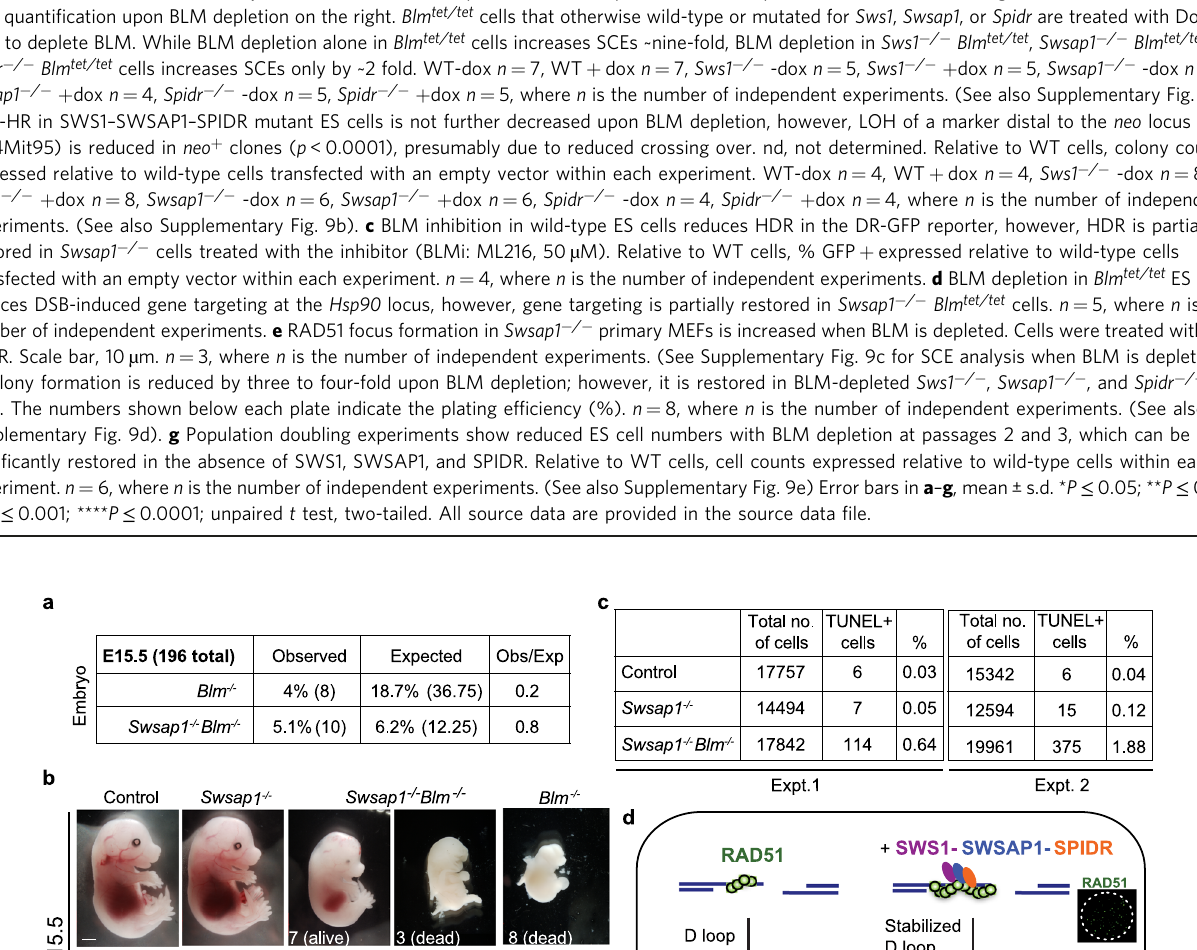
Fig. 3 Mitotic phenotypes associated with BLM depletion are dramatically ameliorated by loss of SWS1 – SWSAP1 – SPIDR. a . Loss of SWS1 – SWSAP1 – SPIDR substantially reduces SCEs in BLM-depleted ES cells. Representative metaphase chromosomes showing SCEs are shown on the left